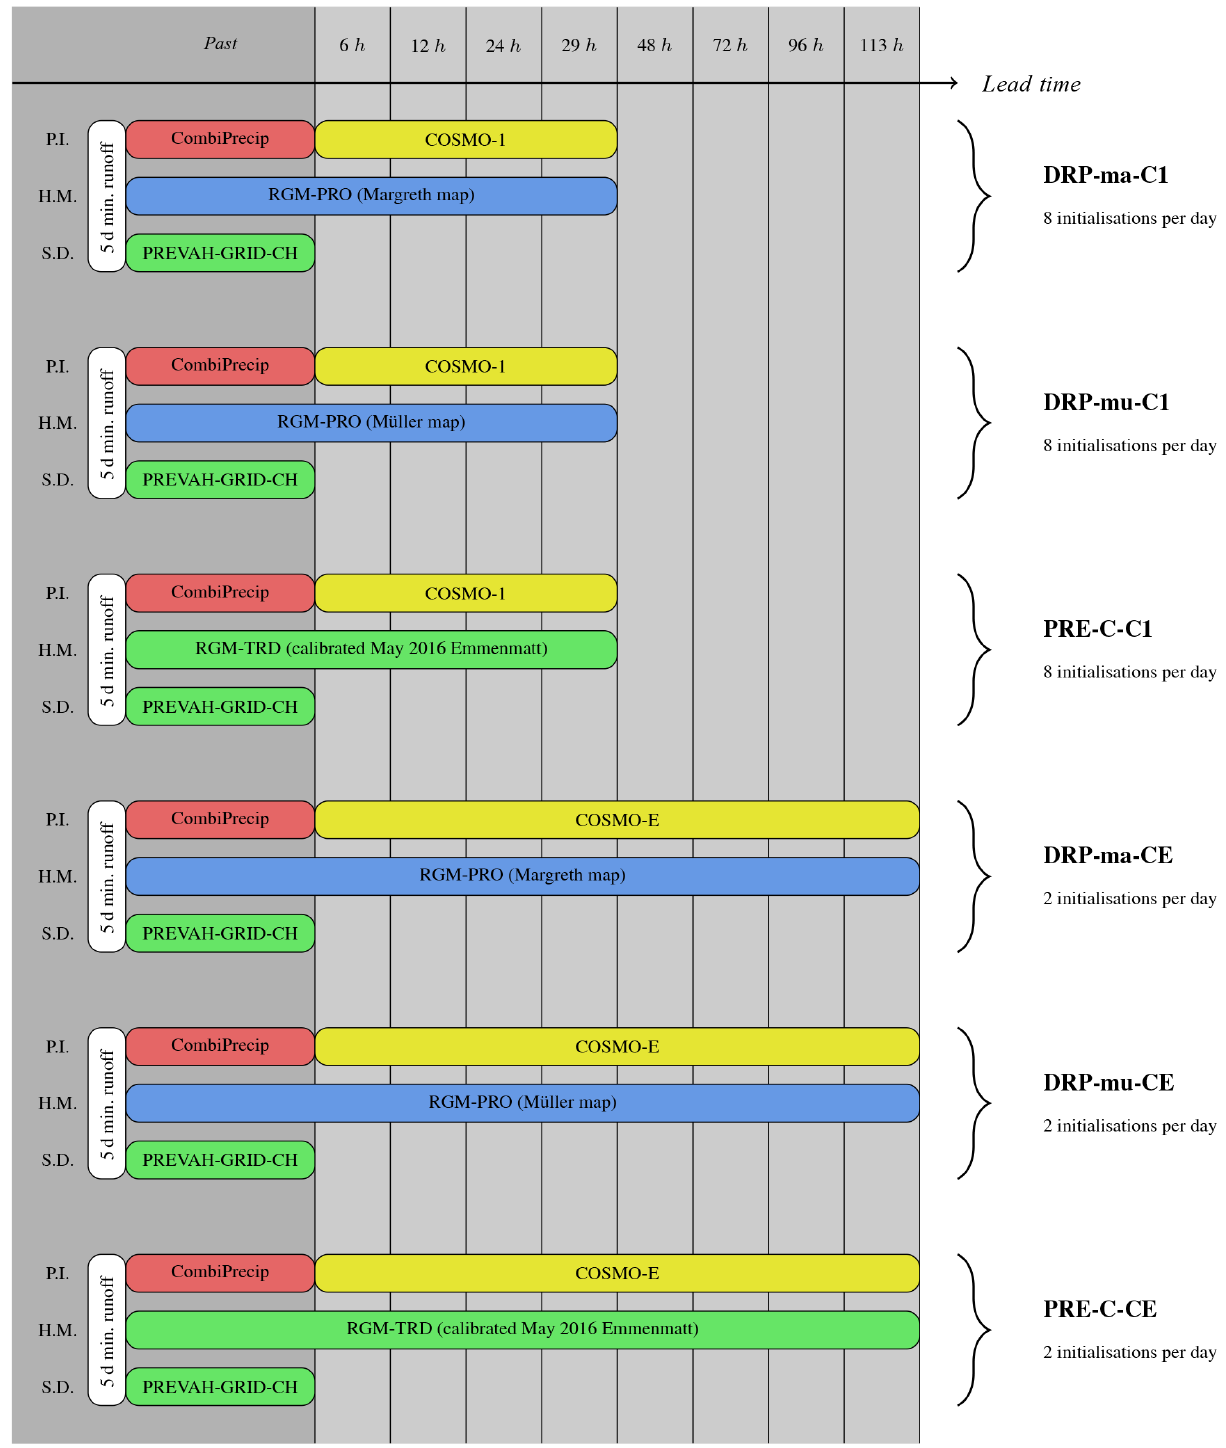
Figure 3. Scheme of the FF forecasting chains in the Emme catchments investigated in this paper, with the key indicated on the right-hand side. On the left-hand side, P.I. stands for precipitation input, H.M. for hydrological model and S.D. for soil moisture data. “5 d min. runoff” represents the minimum observed runoff in the last 5 days prior to the